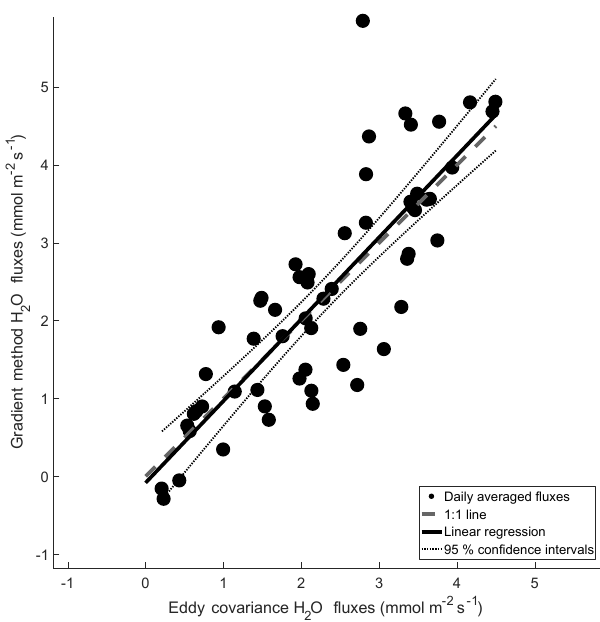
Figure 5. Water vapor fluxes measured via the eddy covariance method ( x axis) vs. those derived from the flux-gradient method ( y axis). The plotted linear regression has a slope of 1.05 and an offset of − 0.08 and explains 70% of the data